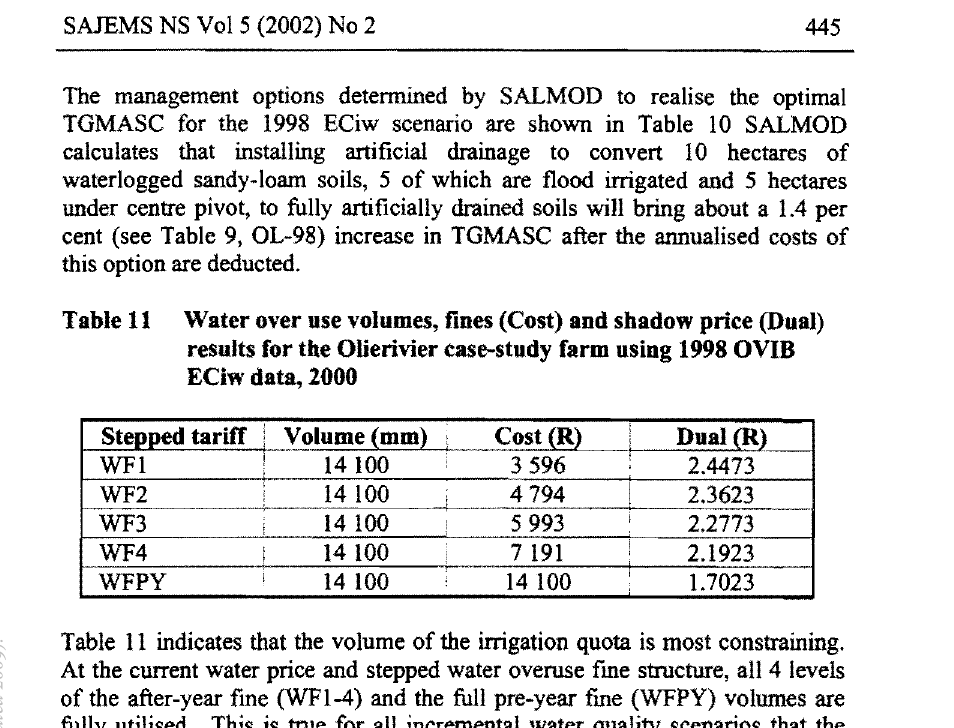
Water over use volumes, fines (Cost) and shadow price (Dual) results for the Olierivier case-study farm using 1998 OVIB